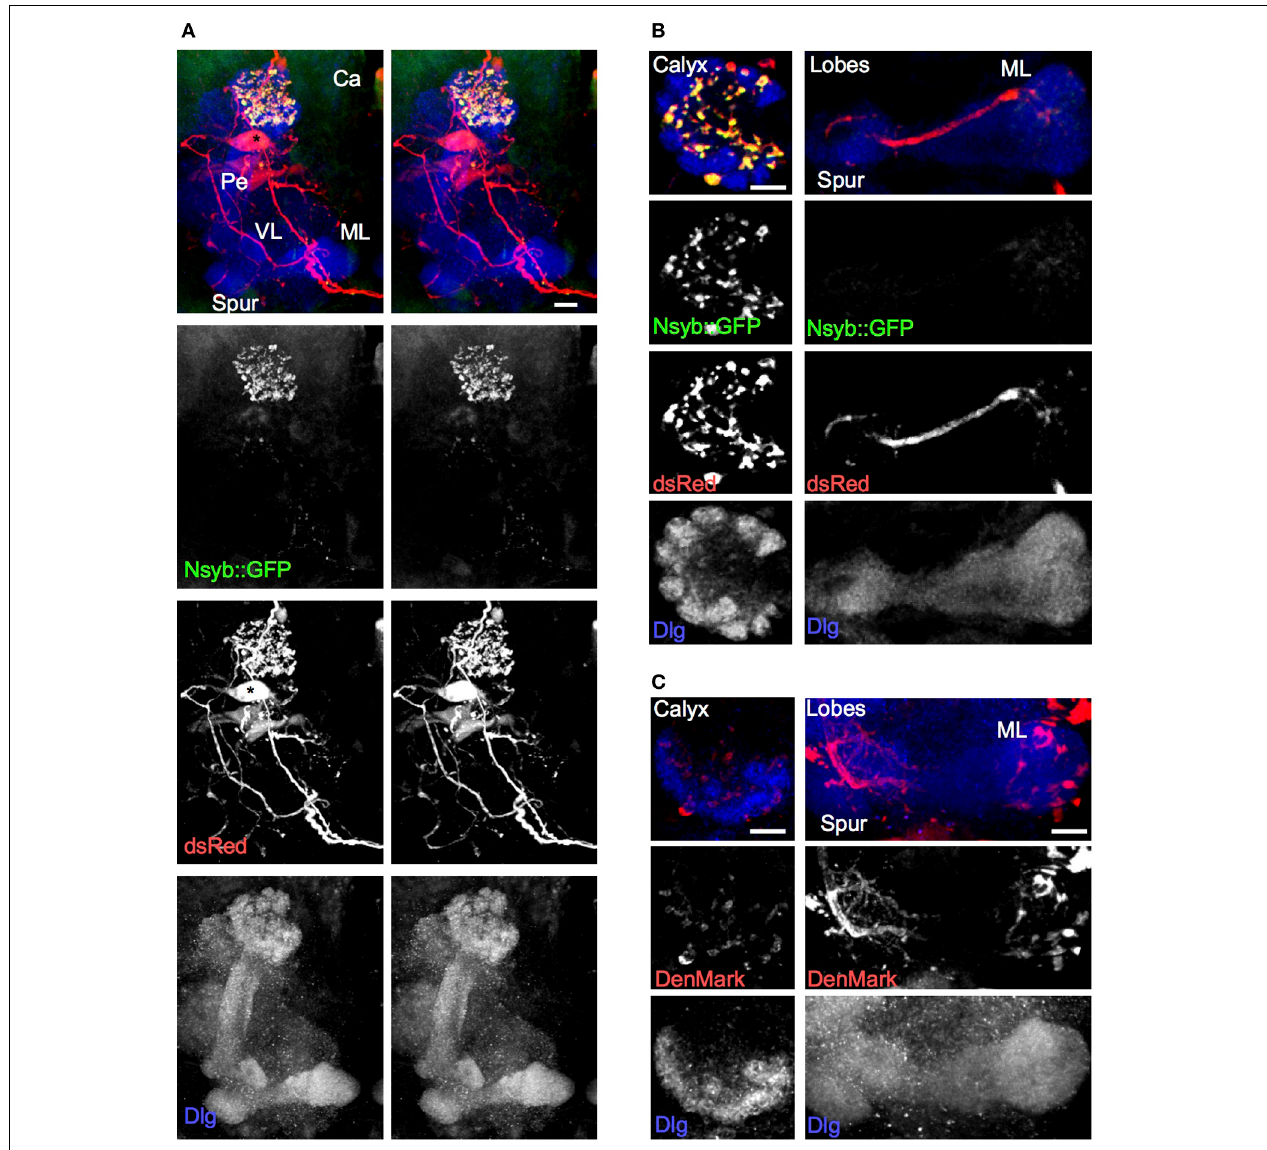
FIGURE 2 | The larval APL neuron has pre-synaptic termini in the calyx, and termini with dendritic characteristics in both lobes and calyx. (A) Using NP0732-GAL4 to express dsRed to label the larval APL cell outline, and nSyb::GFP to label pre-synaptic termini, shows strong labeling of pre-synaptic termini in the calyx, but not in the lobes, spur or pedunculus. (B) Sections through a calyx (left column) and medial lobe (right column) of a brain of the same genotype as (A) .